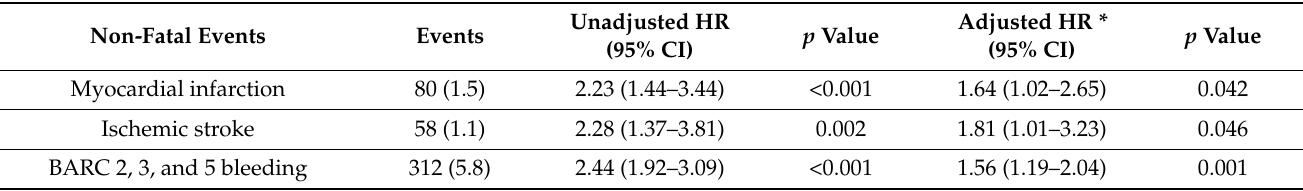
Table 4. Association between non-fatal events within 1 year and all-cause death more than 1 year after percutaneous coronary